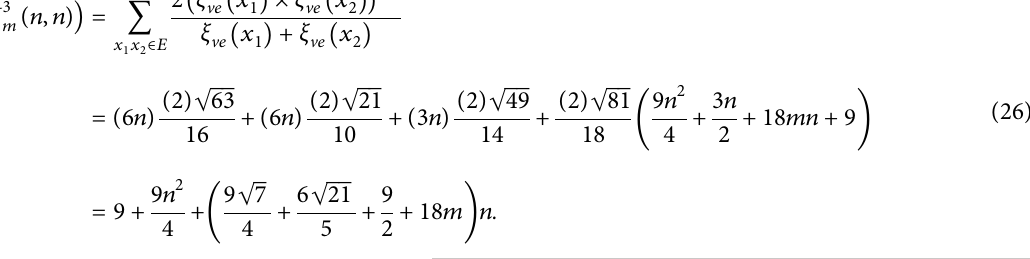
Table 6: Numerical comparison of M 1